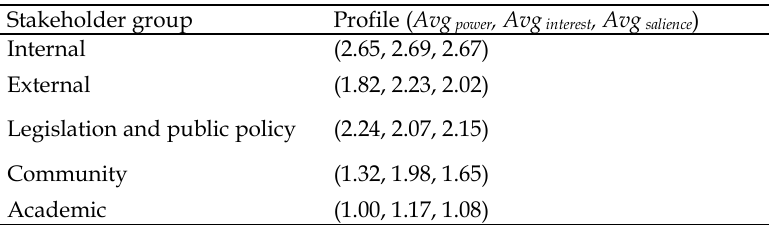
Table 5. The position of the stakeholder groups on the decision surface